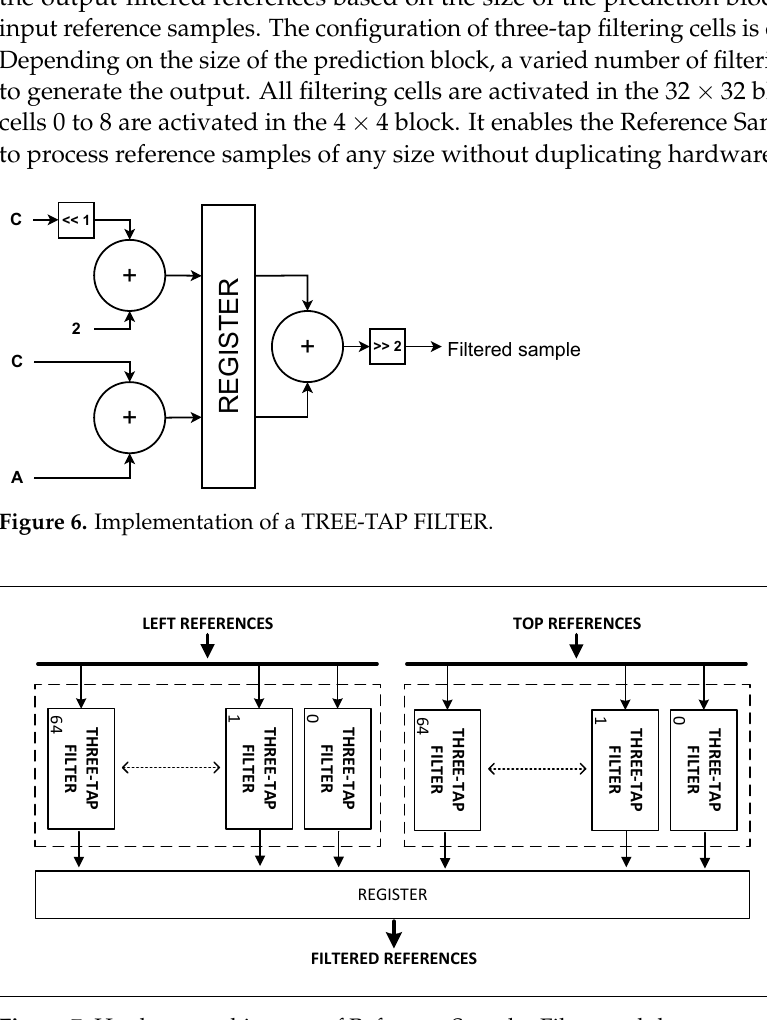
Figure 7. Hardware architecture of Reference Samples Filter